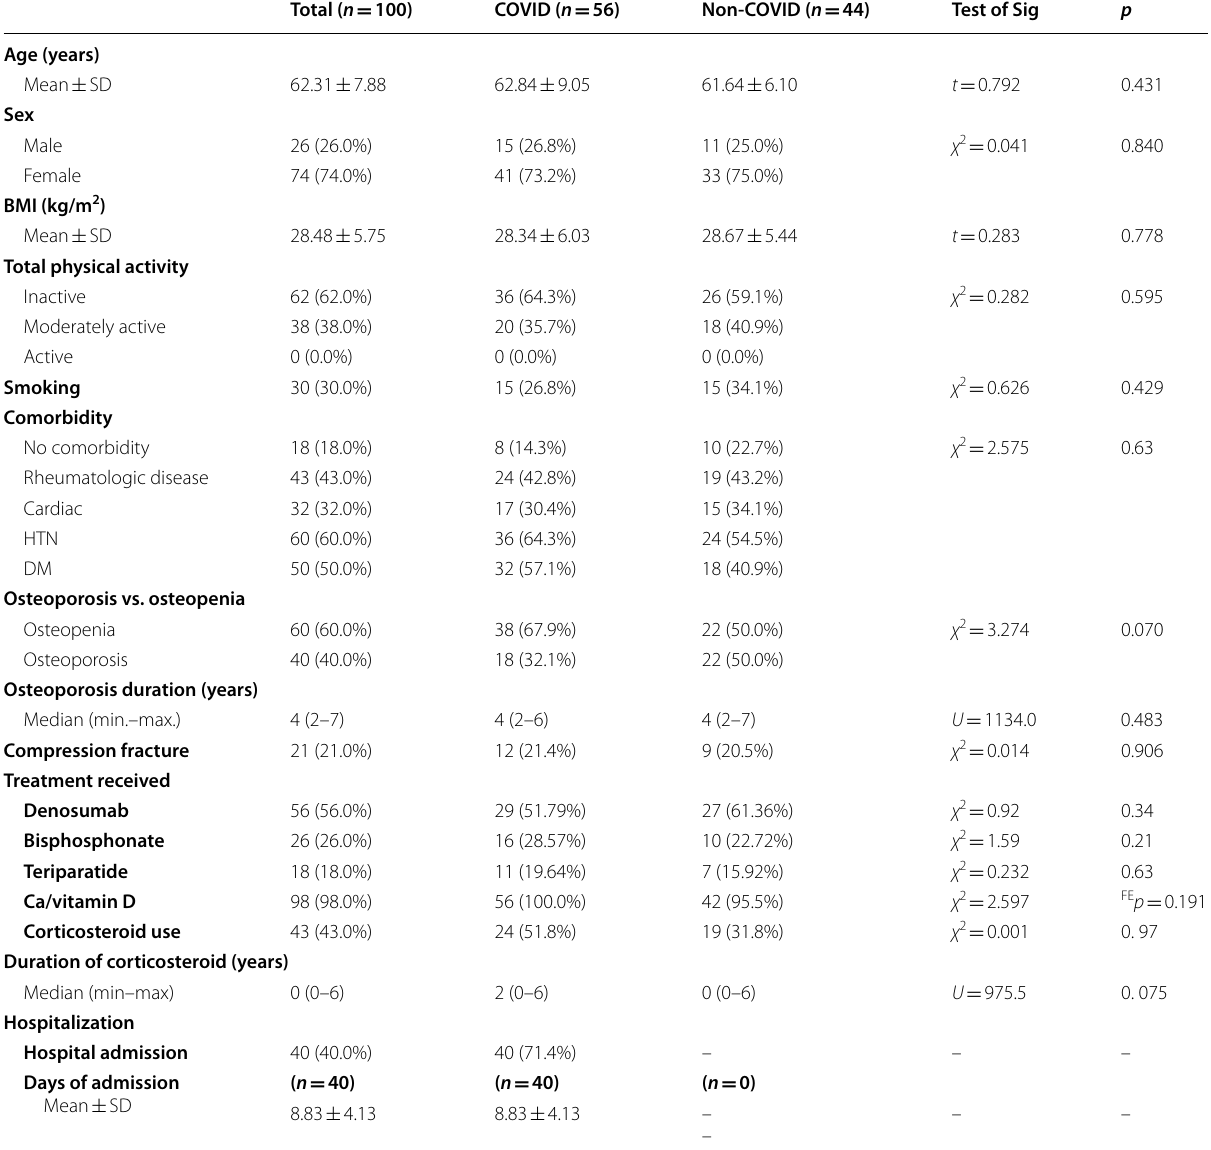
Table 1 Demographic and clinical characteristics data of the patients ( n